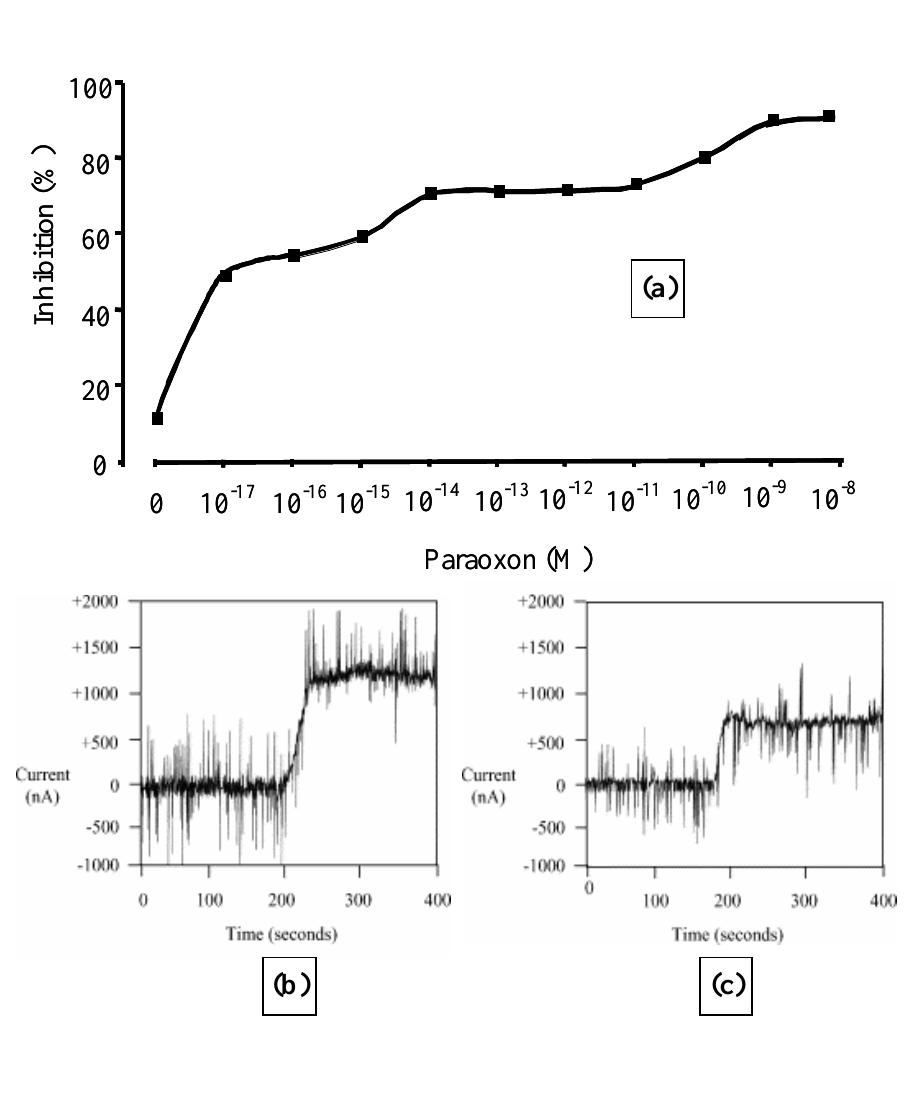
Figure 19. Calibration curve (a) for paraoxon inhibition of acetylcholinesterase-modified CoPC electrodes for paraoxon concentrations between 10 –8 and 10 –17 mol L –1 . Insets